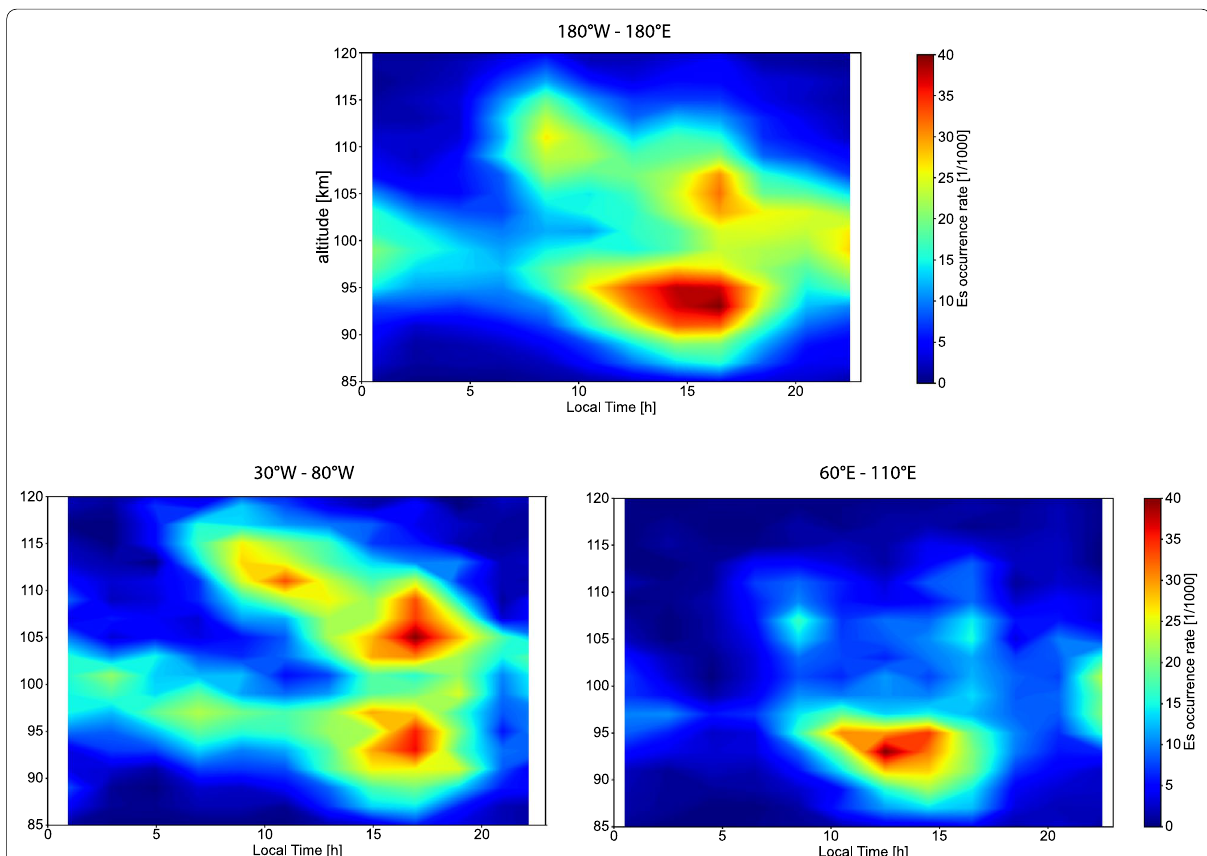
Fig. 10 Local time/altitude cross-sections of equatorial sporadic E occurrence rate in autumn (September, November, December) 2007–2021 in a 1 h x 1 km altitude resolution at different longitude